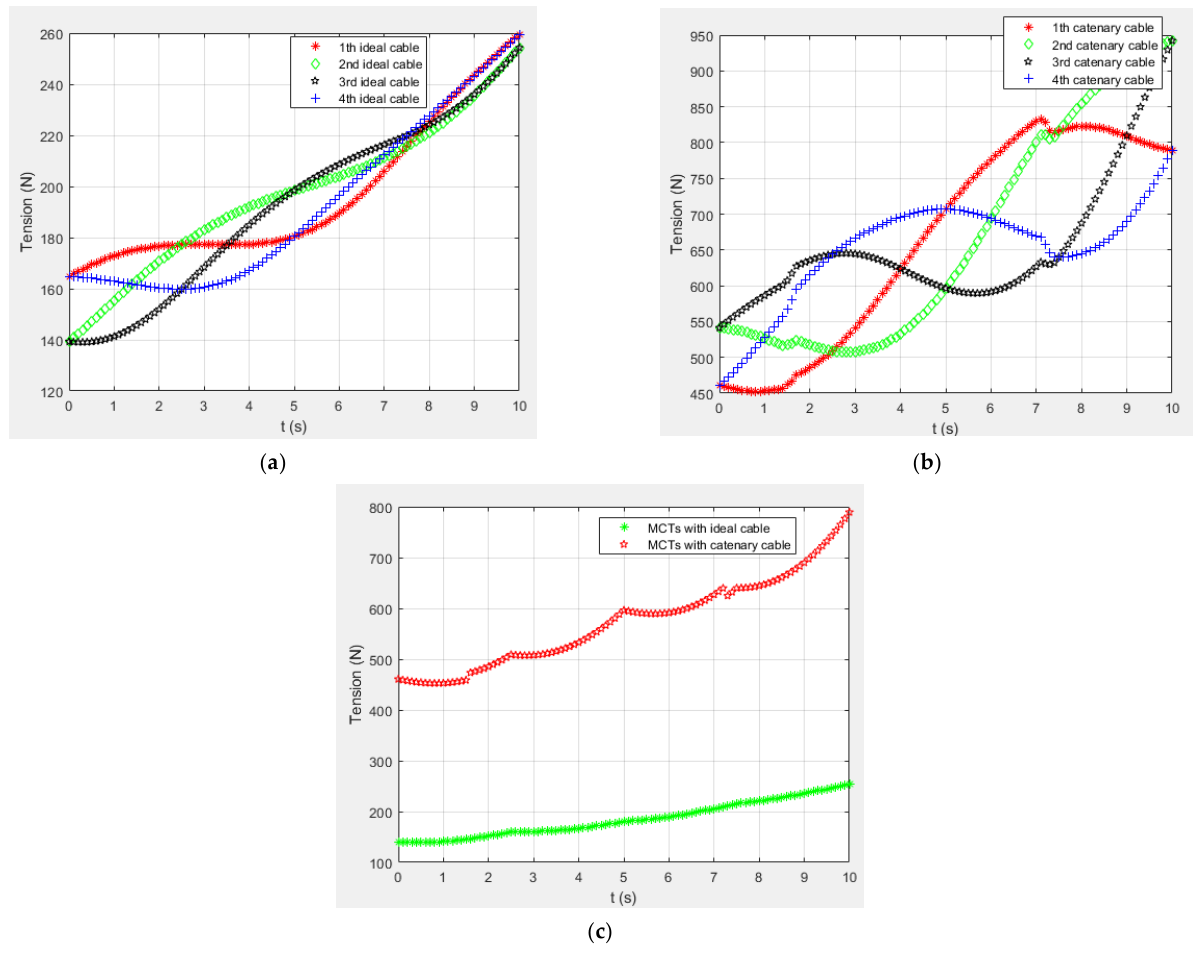
Figure 6. Cable tension with catenary and ideal cables: ( a ) cable tension with the ideal cables, ( b ) cable tension with the catenary cables, ( c ) MCTs with two cable models.